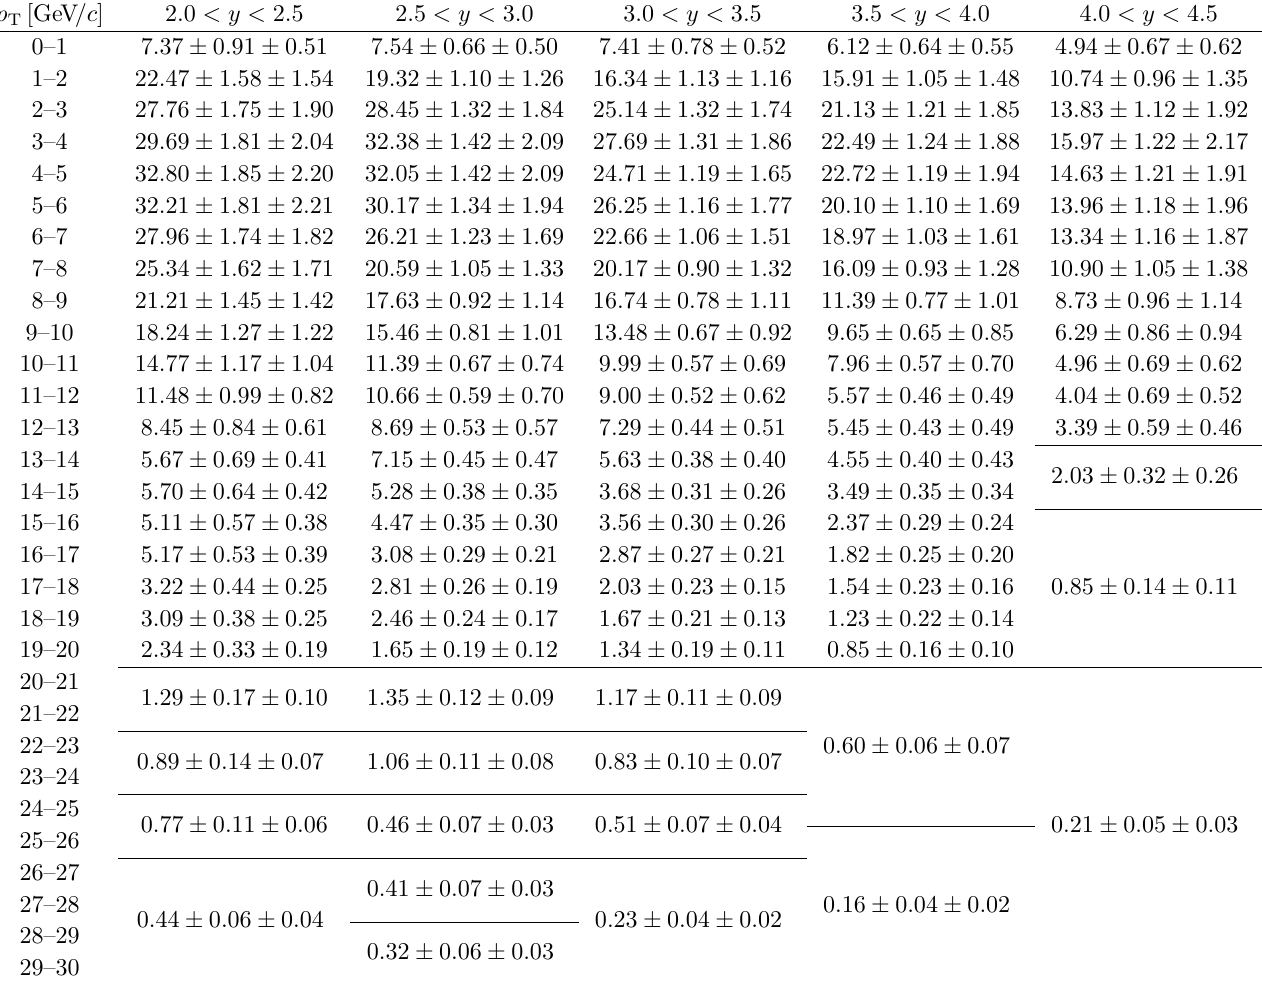
Table 4 . Double-di(cid:11)erential cross-sections times dimuon branching fraction in di(cid:11)erent bins of p T and y for (cid:7) (3 S ) (in pb). The (cid:12)rst uncertainty is statistical and the second is systematic.